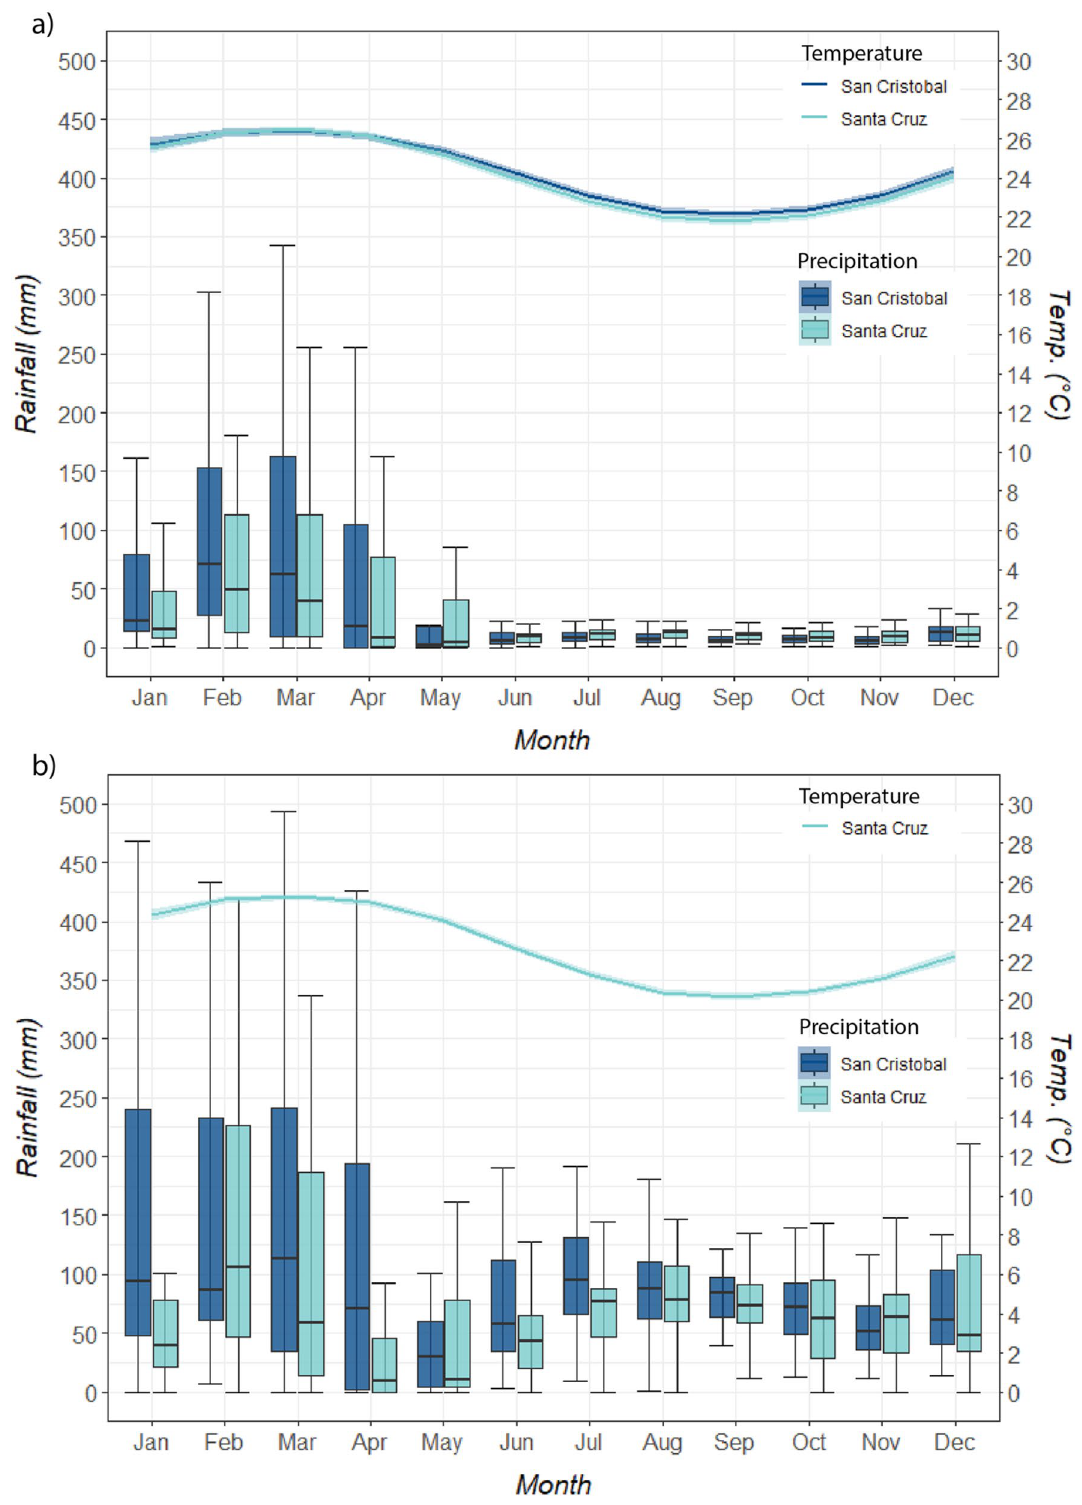
Figure 1. Mean annual precipitation and temperature values as observed by the meteorological stations in Santa Cruz and San Cristobal between 1981 and 2017 for: ( a ) Coastal Regions, ( b ) Highland Regions. Error bars are shown for precipitation and confidence intervals, as shaded areas, (95%) for